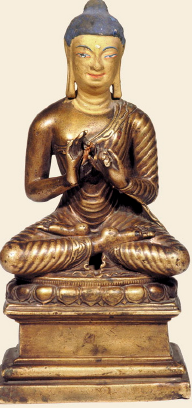
Figure 33. Vairocana Buddha performing the dharmacakra-pravartana mudr ā . 7th c. Kashmir. Brass with cold gold and pigments from Tibet. https://himalayanbuddhistart.files.wordpress.com/2015/08/7th-c- kashmir-shakyamuni-brasspig-232-cm-karkota-potala.jpg.